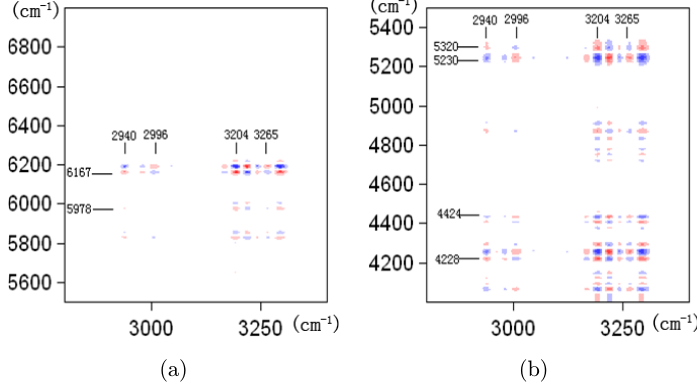
Fig. 4. 2D synchronous correlation spectra of cefmenoxime hydrochloride for injection. (a) Spectrum between the IR region of 3400 – 2800 cm (cid:1) 1 and the NIR region of 7000 – 5500 cm (cid:1) 1 . (b) Spectrum between the IR region of 3400 – 2800 cm (cid:1) 1 and the NIR region of 5500 – 4000 cm (cid:1) 1